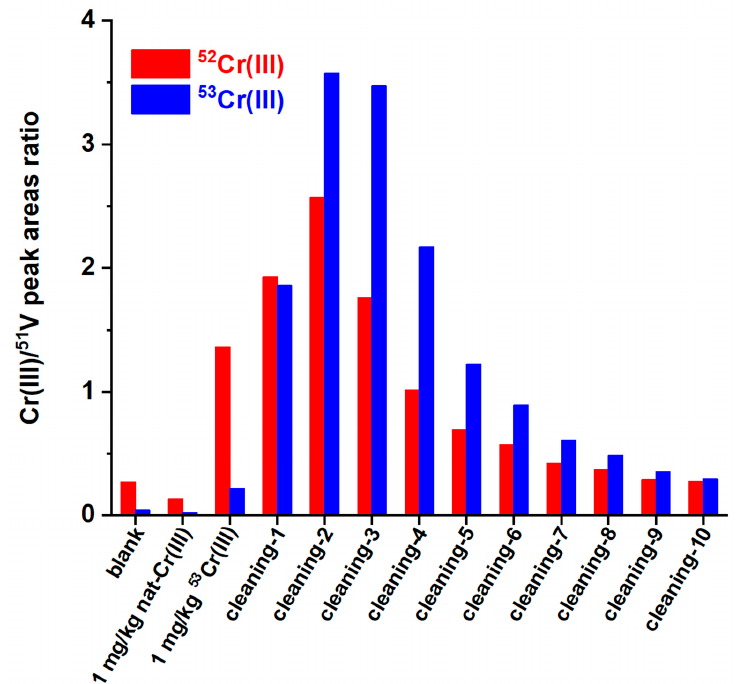
Figure 2. 52 Cr(III)/ 51 V and 53 Cr(III)/ 51 V peak area ratios of a sequence (from left to right) of various blank and standards injections: areas determined on the cationic Cr(III) peak (first peak in Figure 1).